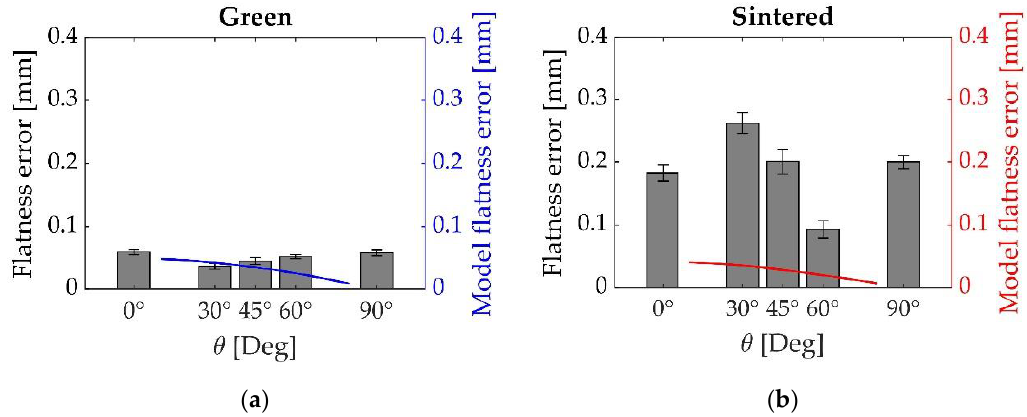
Figure 6. ( a ) Flatness form error of plane D measured in the green state along with the flatness predicted by Equation (1); ( b ) flatness form error of plane D measured in the sintered state along with the flatness predicted by Equation (2). The error bars represent one standard deviation in the measurements.